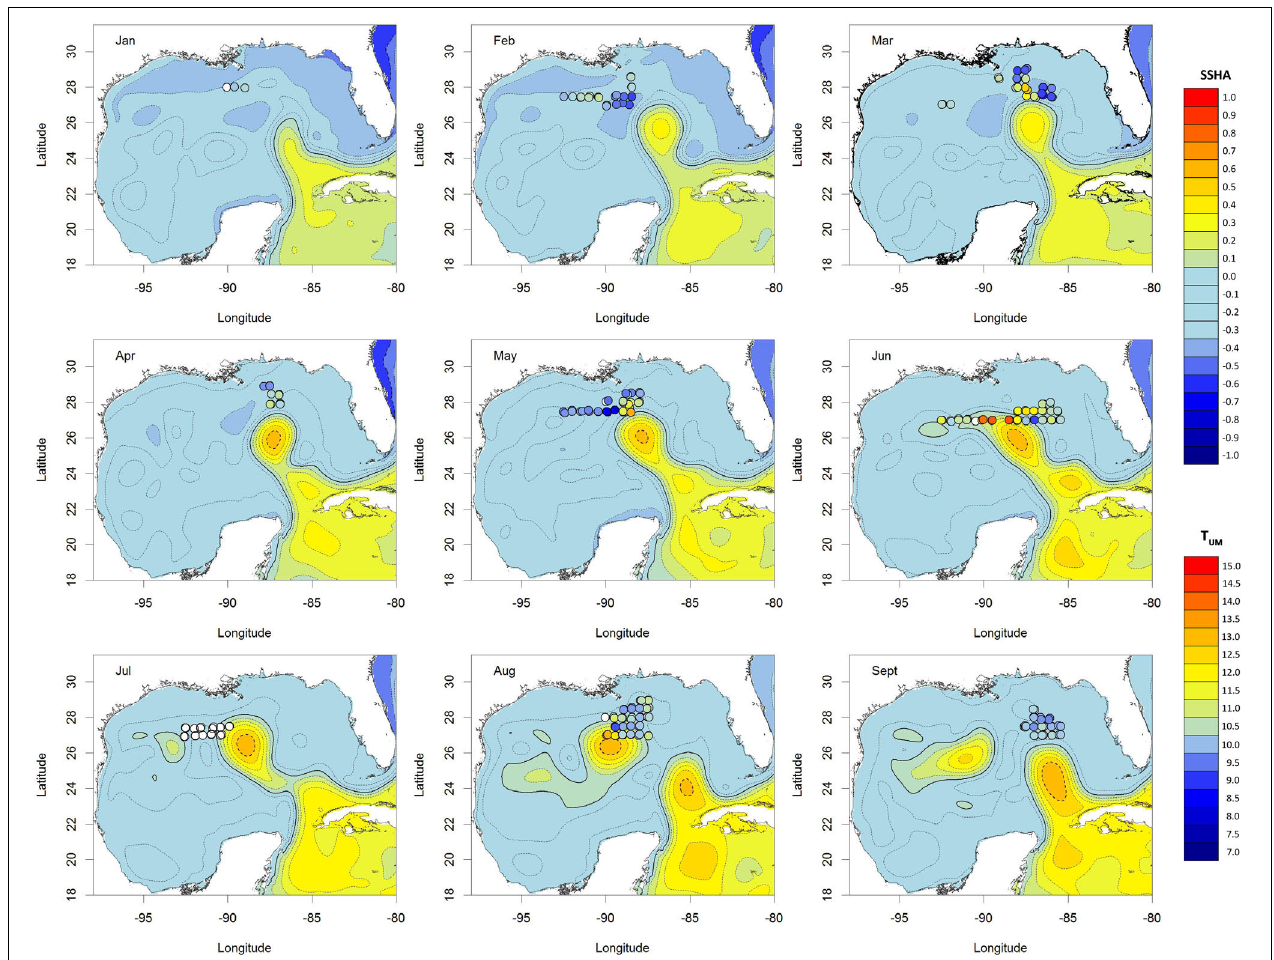
FIGURE 2 | Maps showing satellite-derived, integrated SSHA data per month (from CMEMS). Contour lines mark 0.1 m intervals; 0 m is indicated by the solid line. Each point is a MOCNESS sample, colored according to the T UM at the time of collection. White points indicate no MOCNESS sensor data were available. Chart datum: